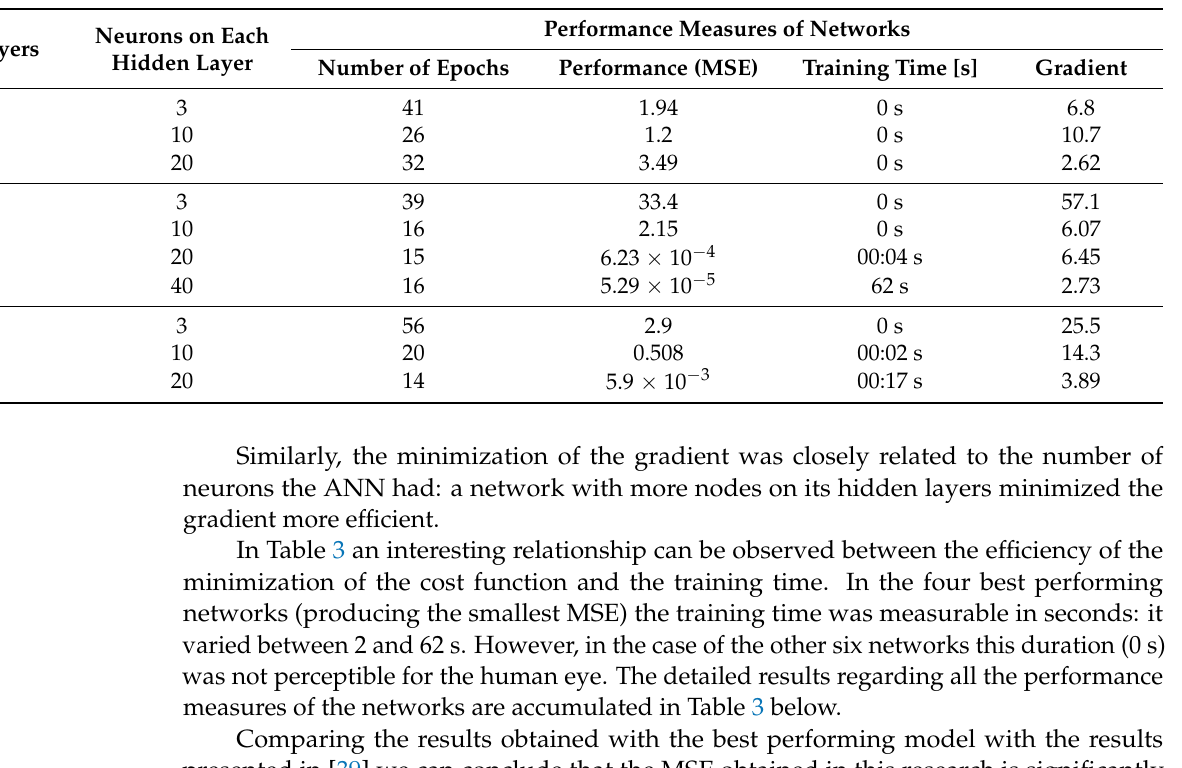
Table 3. Performance of the 10 trained neural